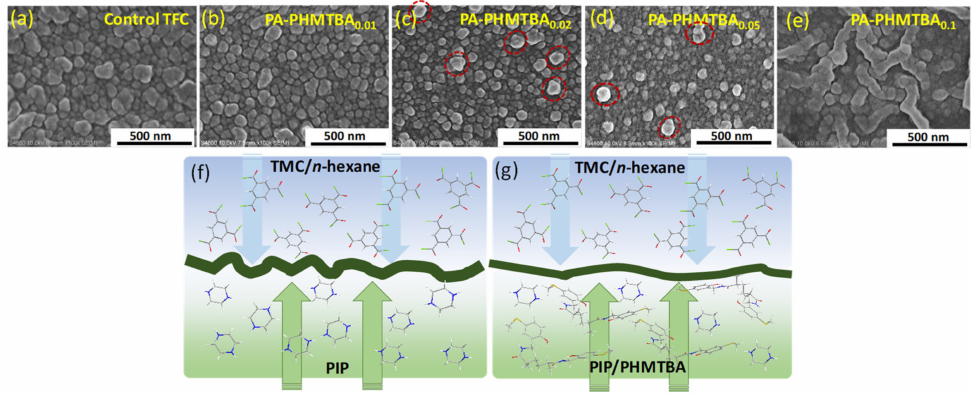
Figure 5. ( a – e ) SEM surface images and ( f , g ) schematic diagrams of the interfacial diffusion process of unmodified and PHMTBA-modified TFC membranes. (The red coils in ( c , d ) represented the particle-like